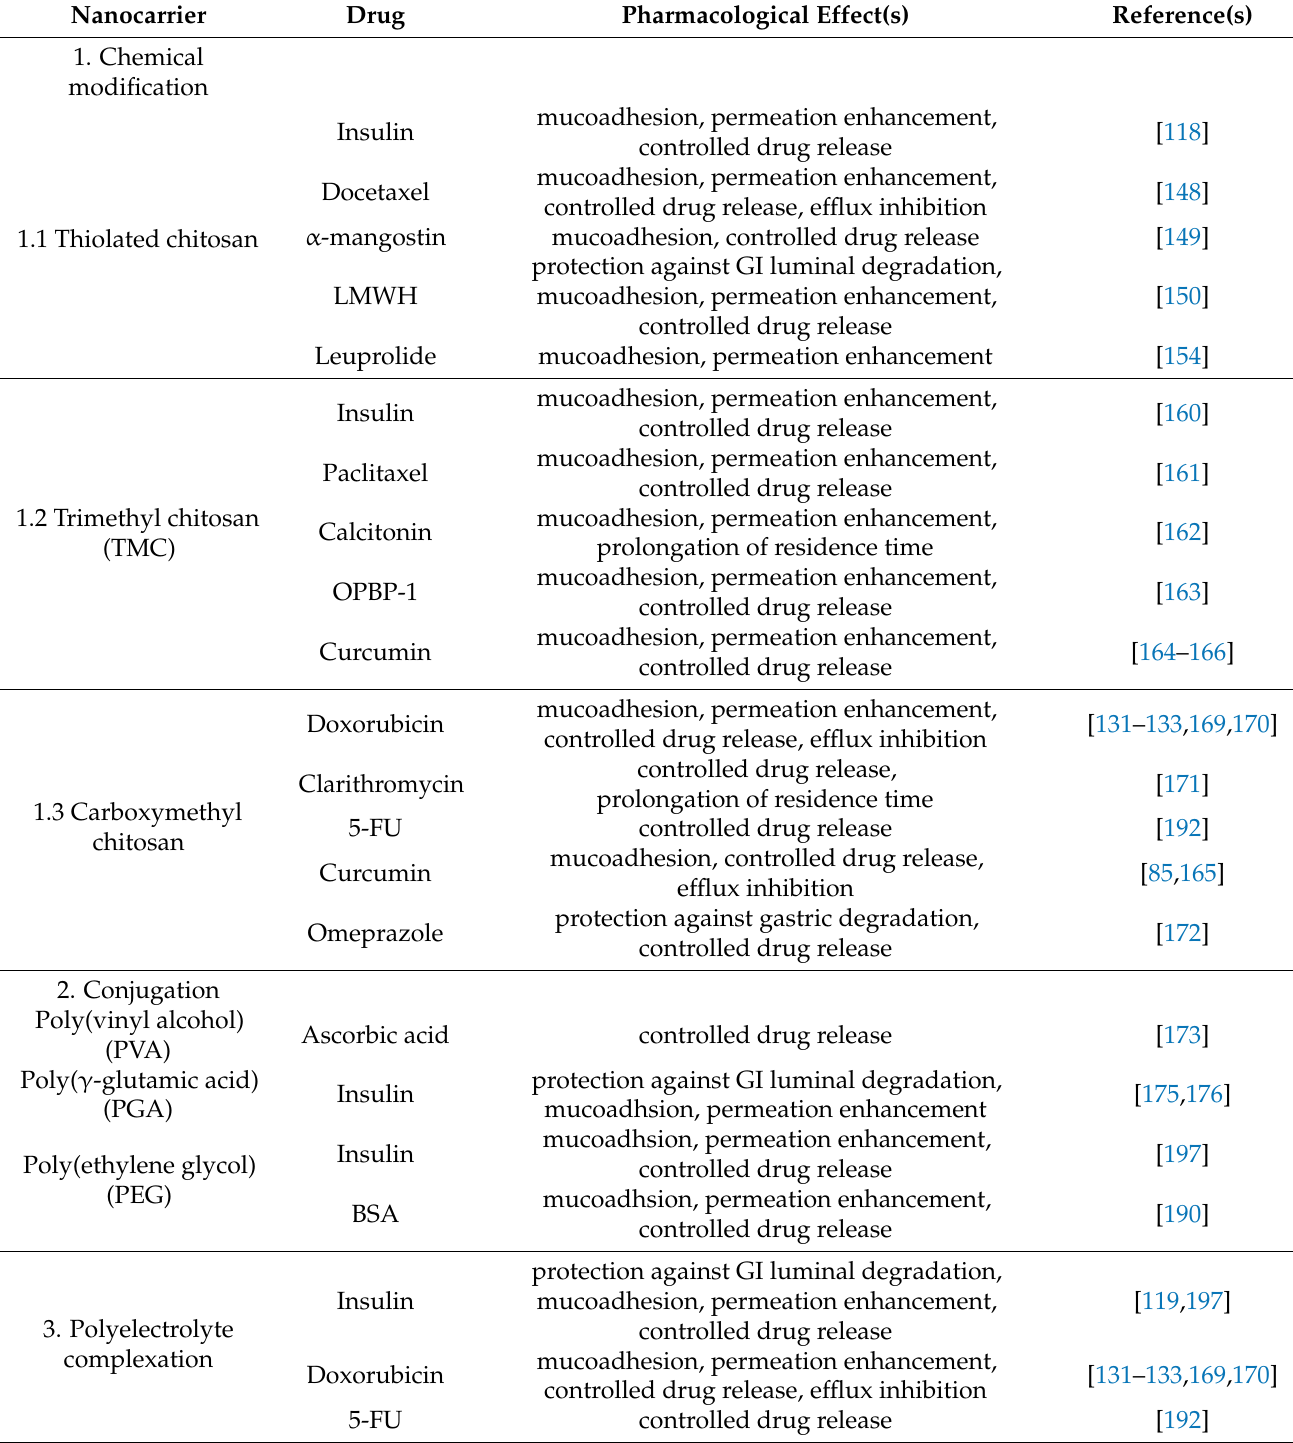
Table 1. Summary of chitosan-based nanocarriers used for improving the absorption of indicated drugs and their pharma- cologic effects. This table summarizes the chitosan-based nanomaterials that carry the considerable drugs for better drug assimilation. The nanocarriers, loading drugs, and their exerting pharmacological effects are listed with their attainable ref- erences. Abbreviations: LMWH, low-molecular weight heparin; OPBP-1, Oral PD-L1 Binding Peptide 1; 5-FU, 5-flurouracil; BSA, bovine serum